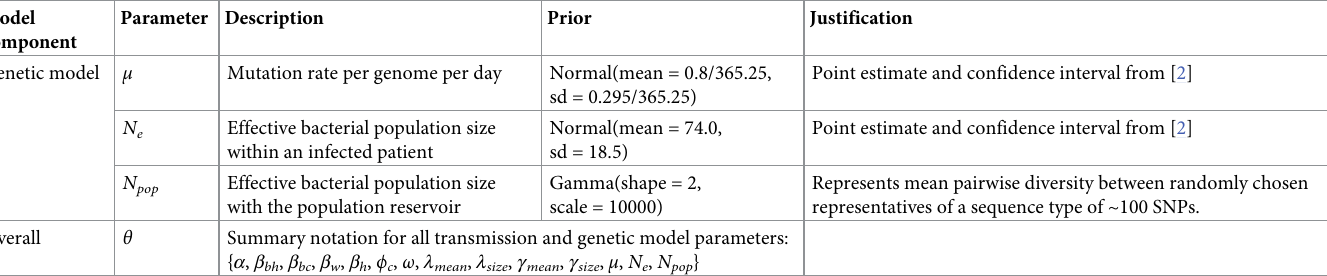
Table 3. Genetic model parameters and priors. For parameters constrained to be positive, normal priors were truncated at zero. Model Parameter Description component